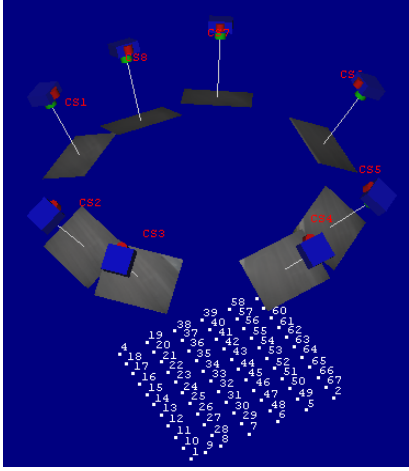
Figure 5. Mosaic of the images and points where the photos were taken